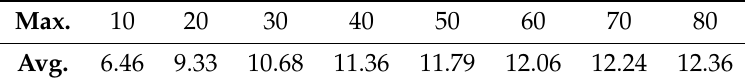
Table 1. The average home size vs. the maximum home